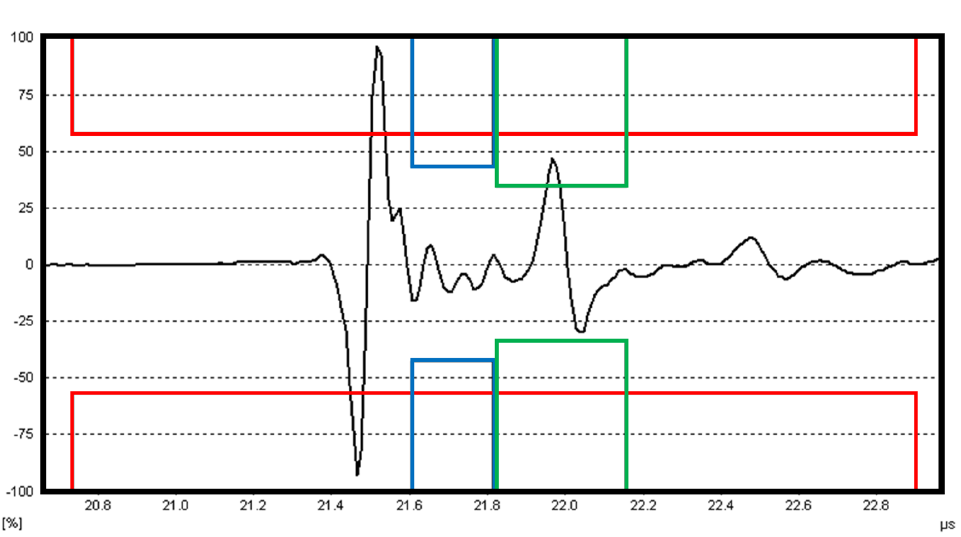
Figure 2. The ultrasonic experimental setup.